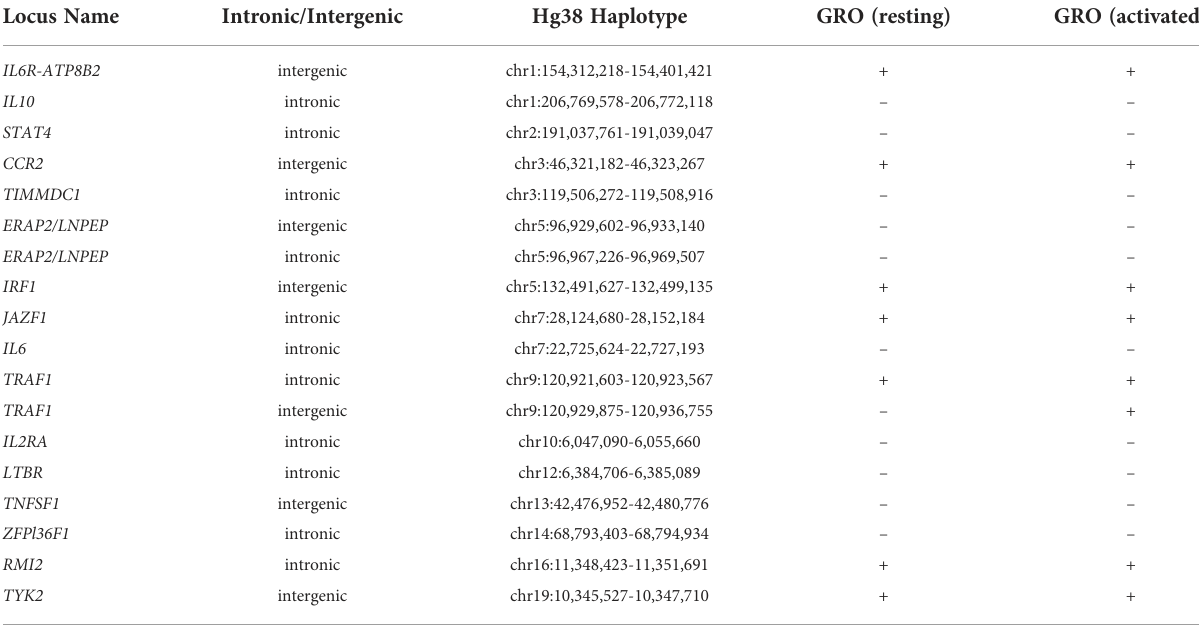
TABLE 5 GROseq peaks that overlap SNPs detected on MPRA in resting K562 cells.